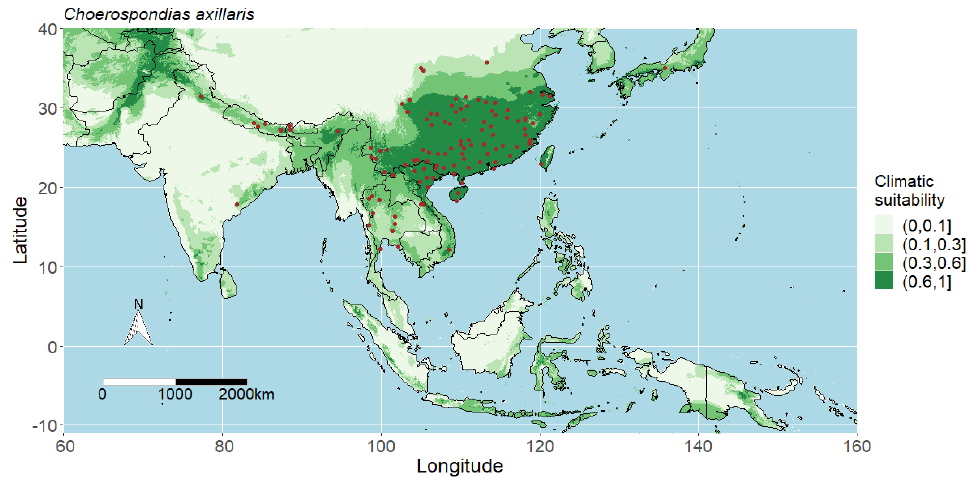
Figure 3. Choerospondias axillaris : confirmed records (brown circles) and potential current climate suitability, modelled from climatic variables (green)—darker green represents higher climatic suitability. Four classes of climatic suitability are (i) <0.1 = “unsuitable”, (ii) 0.1–0.3 = “low suitability”, (iii) 0.3–0.6 = “suitable”, and (iv) >0.6 = “highly suitable” .